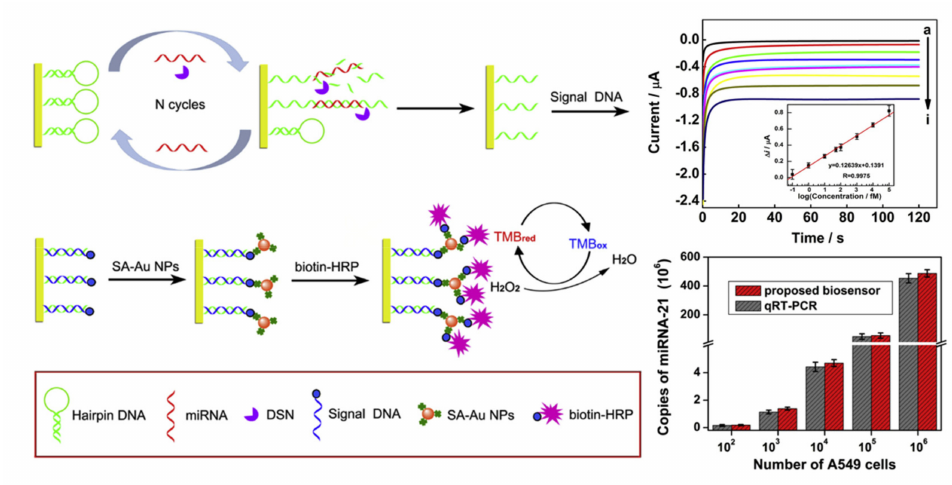
Figure 4. Electrochemical biosensor for miR-21 detection based on triple signal amplification approach, displaying excellent sensitivity with sensing performance comparable to that of qRT-PCR. Reprinted from [60] with permission from